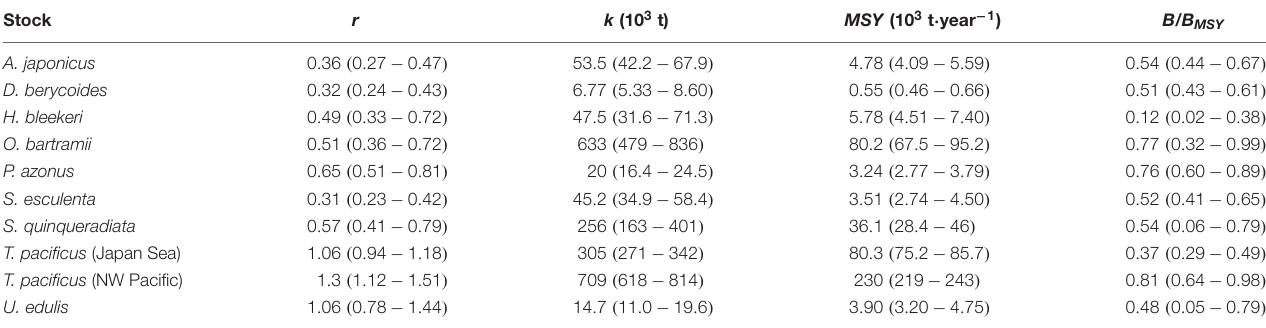
TABLE 5 | Summary of r , k , MSY, B end / k and B / B MSY , with confidence limits (in brackets) estimated by the CMSY and the BSM methods for the 10 stocks in the Northwest Pacific.